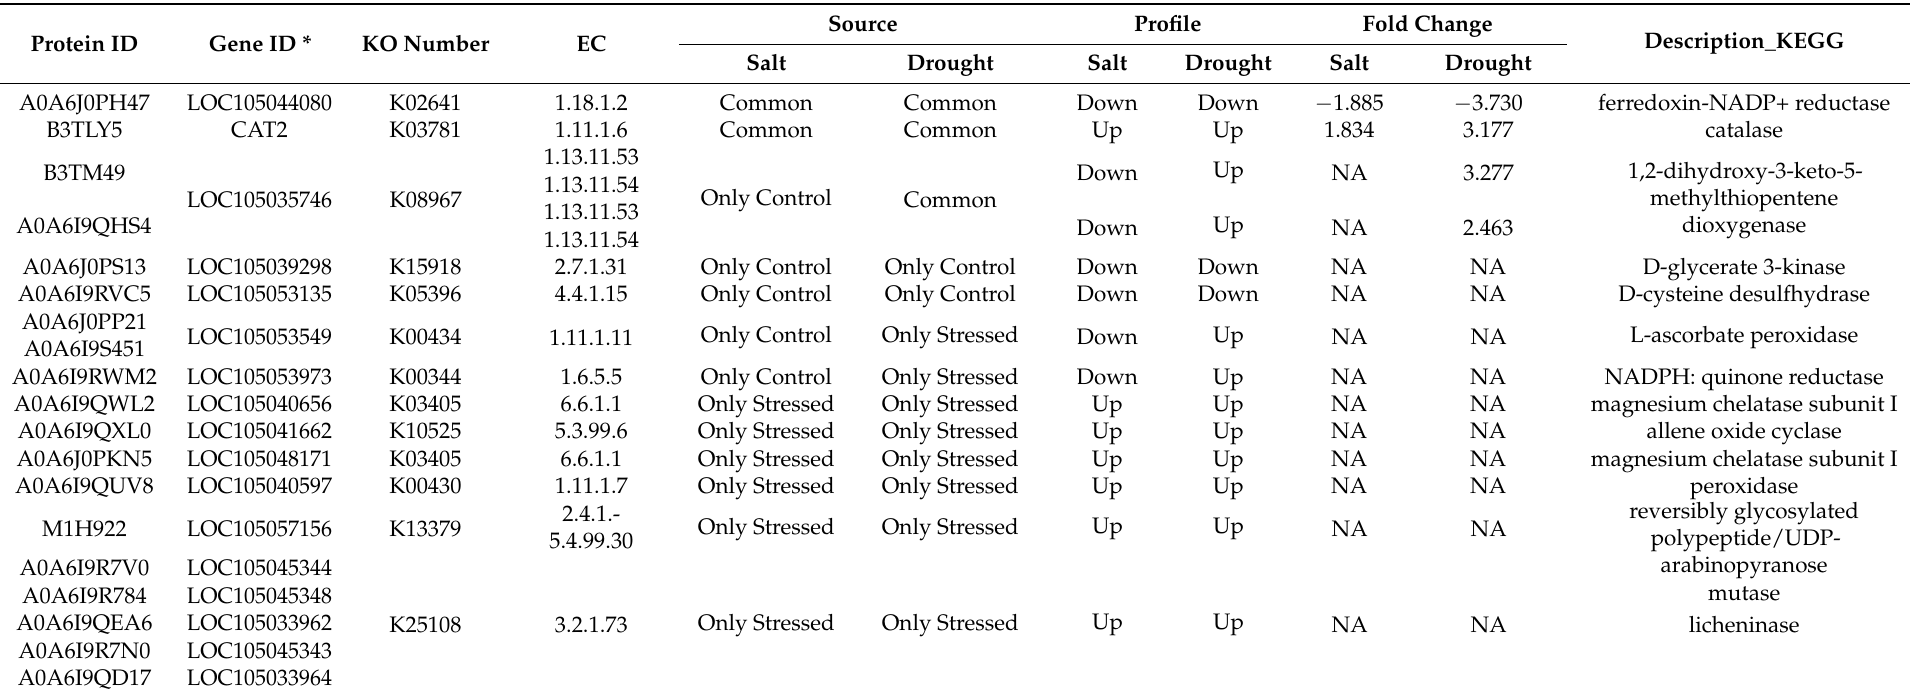
Table 3. Enzymes differentially expressed in the leaf of young oil palm plants under both drought and salinity stresses. Protein